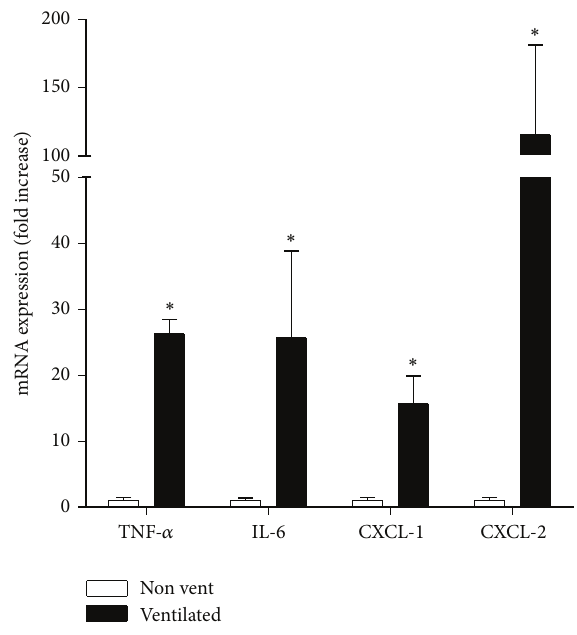
Figure 4: Quantitative PCR of TNF- 𝛼 , IL-6, CXCL-1, and CXCL-2 expressed in MLEC in response to lung perfusate alone or treatment with CAPE or IMD during lung perfusate exposure. ∗ 𝑃 < 0.05 versus Lung perfusate, ± SEM.